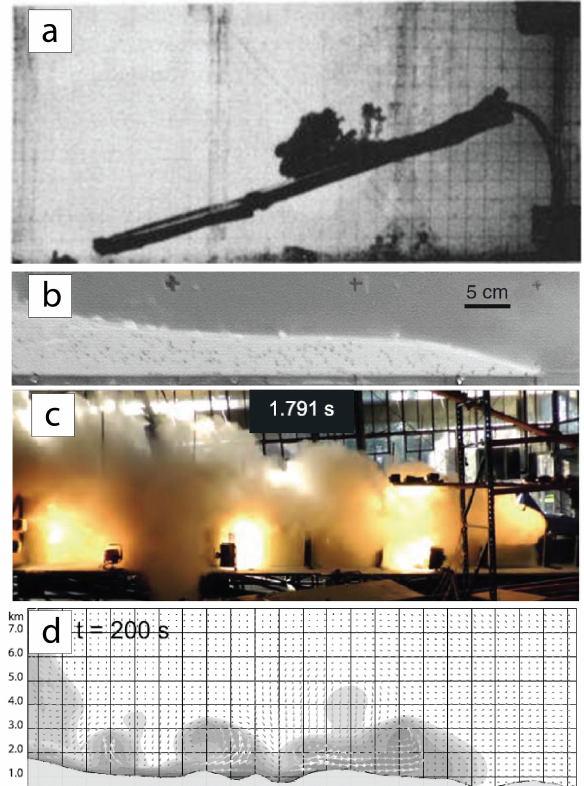
Figure 13. (a) Example of early analogue experiments of partic- ulate flows whereby a mixture of methanol, ethylene glycol, and water was released on a slope into a tank of freshwater. The higher density of the mixture in comparison with the ambient fluid means it flows down slope as a gravity current, forming turbulent eddies at the top of the flow (Woods and Bursik, 1994). (b) Small-scale ex- perimental model set-up designed to investigate particle interactions in detail (Roche, 2012). (c) Large-scale analogue experiments using the PELE set-up, allowing large-scale processes within pyroclastic density currents to be investigated. The figure shows emplacement of a dilute mixture of particles and air (Lube et al., 2015). (d) Re- sults from application of the multiphase numerical model PDAC to the blast phase of the Mount St Helens blast of 18 May 1980 (Es- posti Ongaro et al., 2012). The model results reproduce numerous features of the flows that originated from the blast, including the formation of turbulent